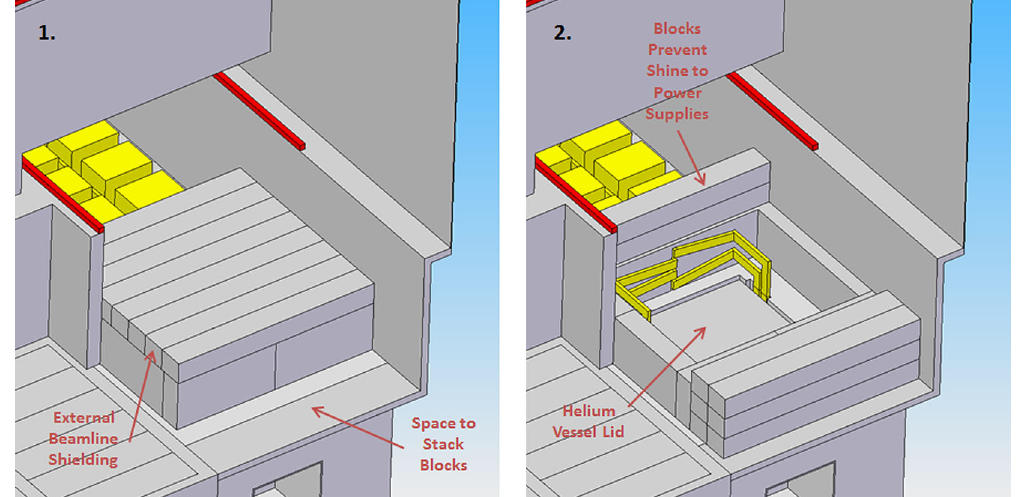
FIG. 13. External shielding of helium vessel: (1) closed and (2) open to access vessel.